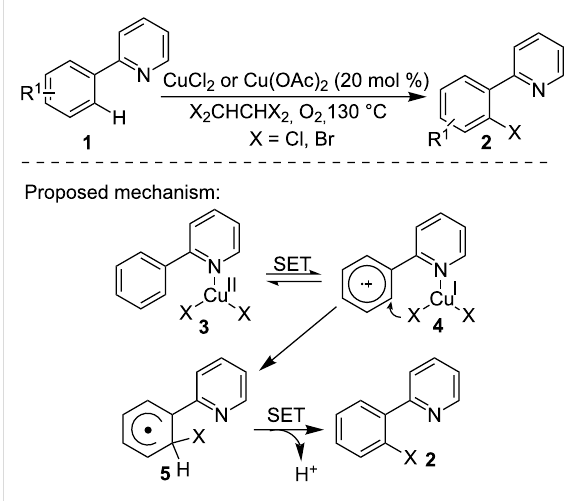
Scheme 1: Copper-catalyzed C–H bond halogenation of 2-arylpyri-